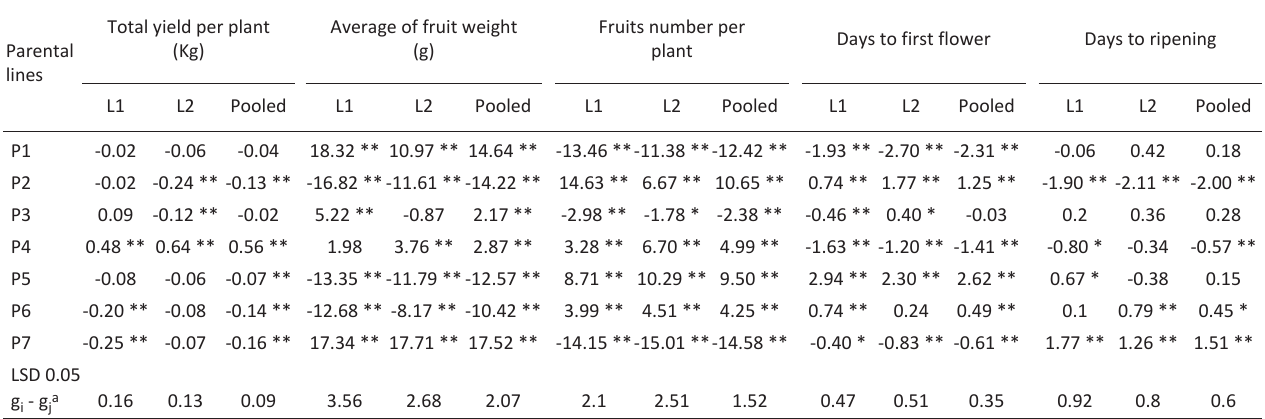
Table 6 - General combining ability (GCA) effects of parental lines for yield, yield components and earliness in a 7×7 diallel cross over two light conditions